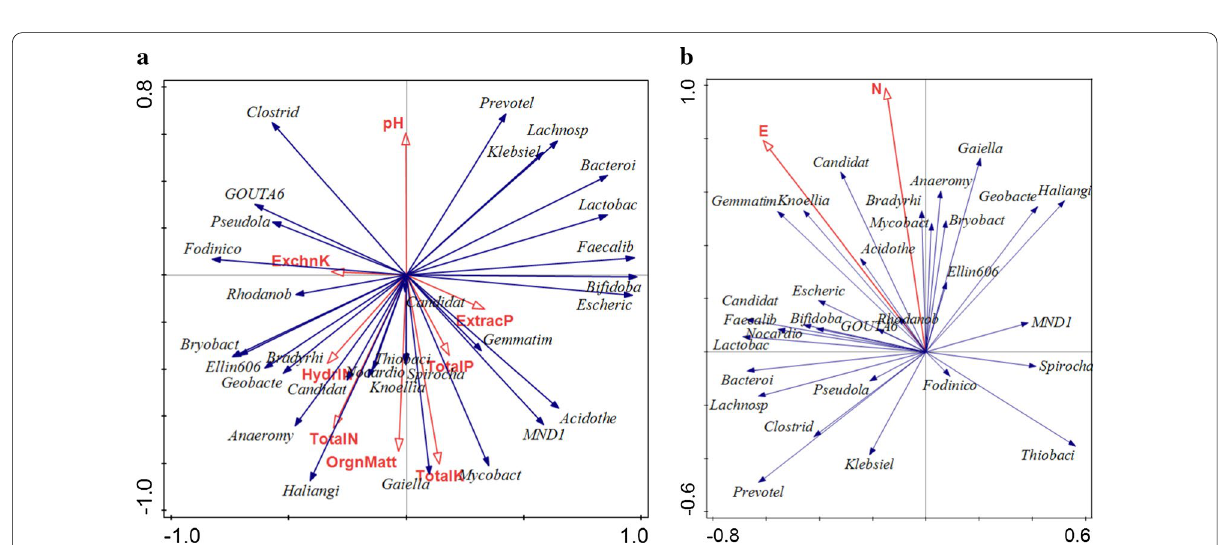
Fig. 6 Redundancy analysis (RDA) of microbial community and soil chemical properties ( p value samples at five rice paddy sites. E: East longitude, N: Northern latitude, ExchnK: Exchangeable K, HydrIN: Hydrolytic N, ExtracP: Extractable